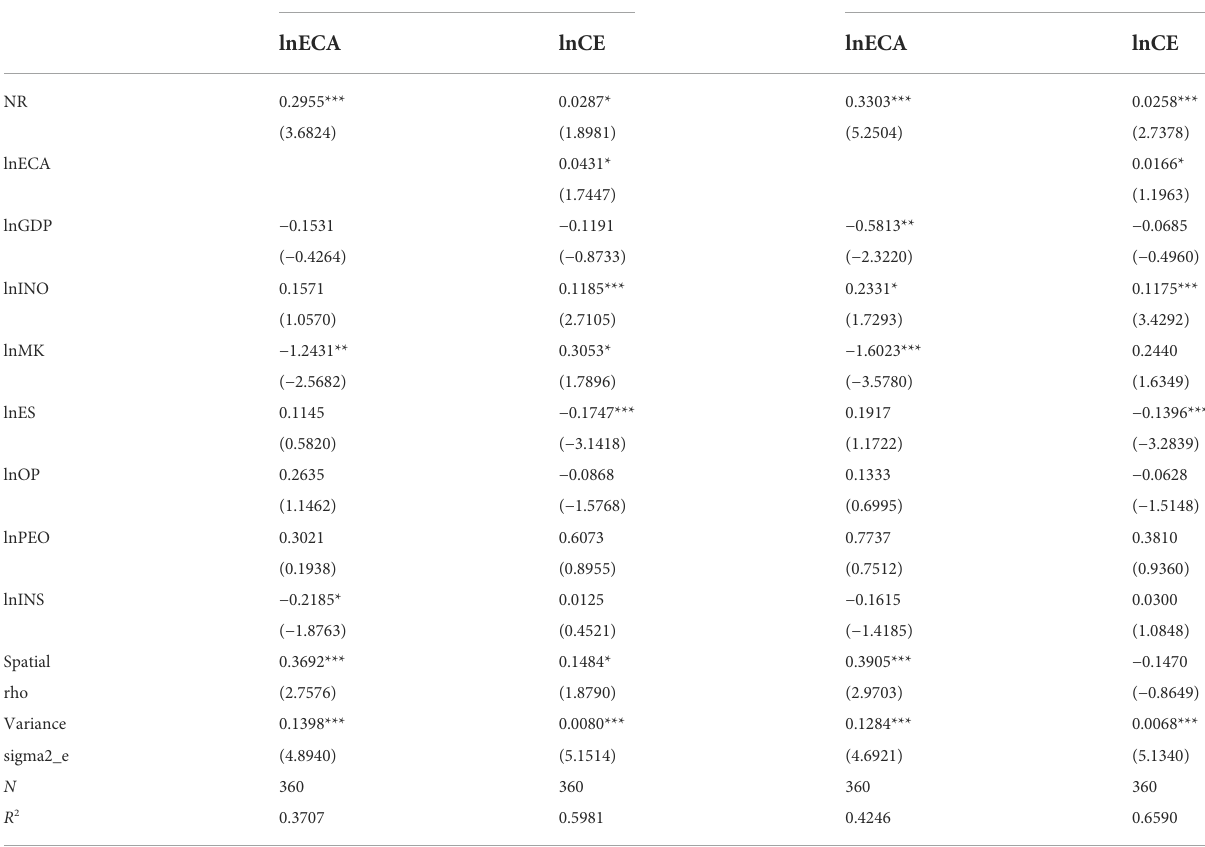
TABLE 7 Test results of intermediary effect.